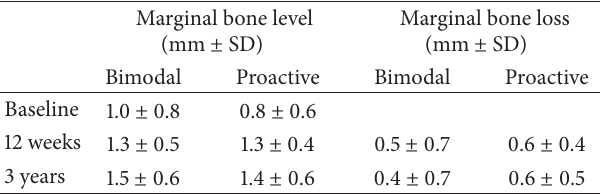
Table 2: Results from radiographic